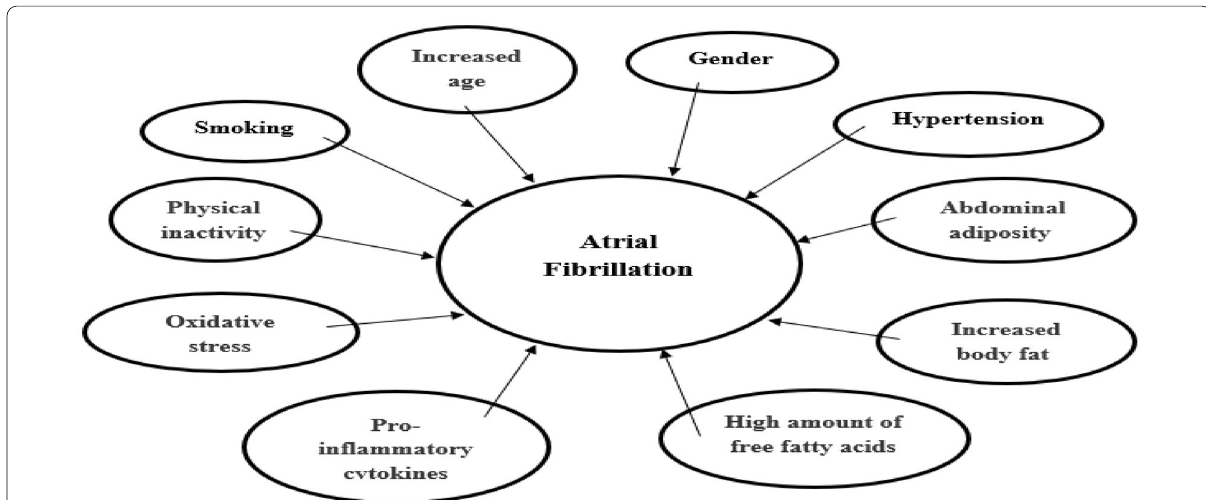
Fig. 1 Several risk factors of insulin resistance are also risk factors for the development and pathogenesis of AF. Source: Designed by the author with the help of review